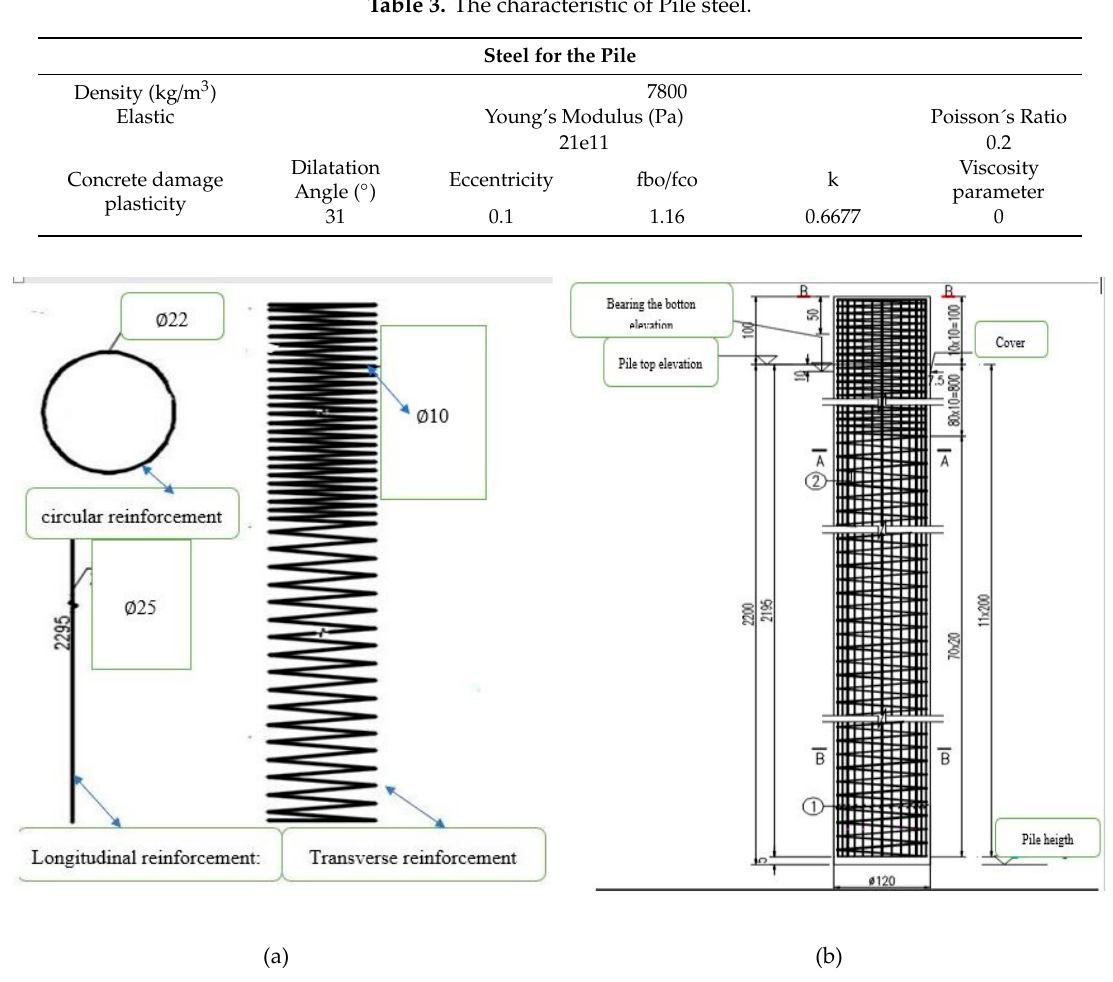
Table 3. The characteristic of Pile steel.